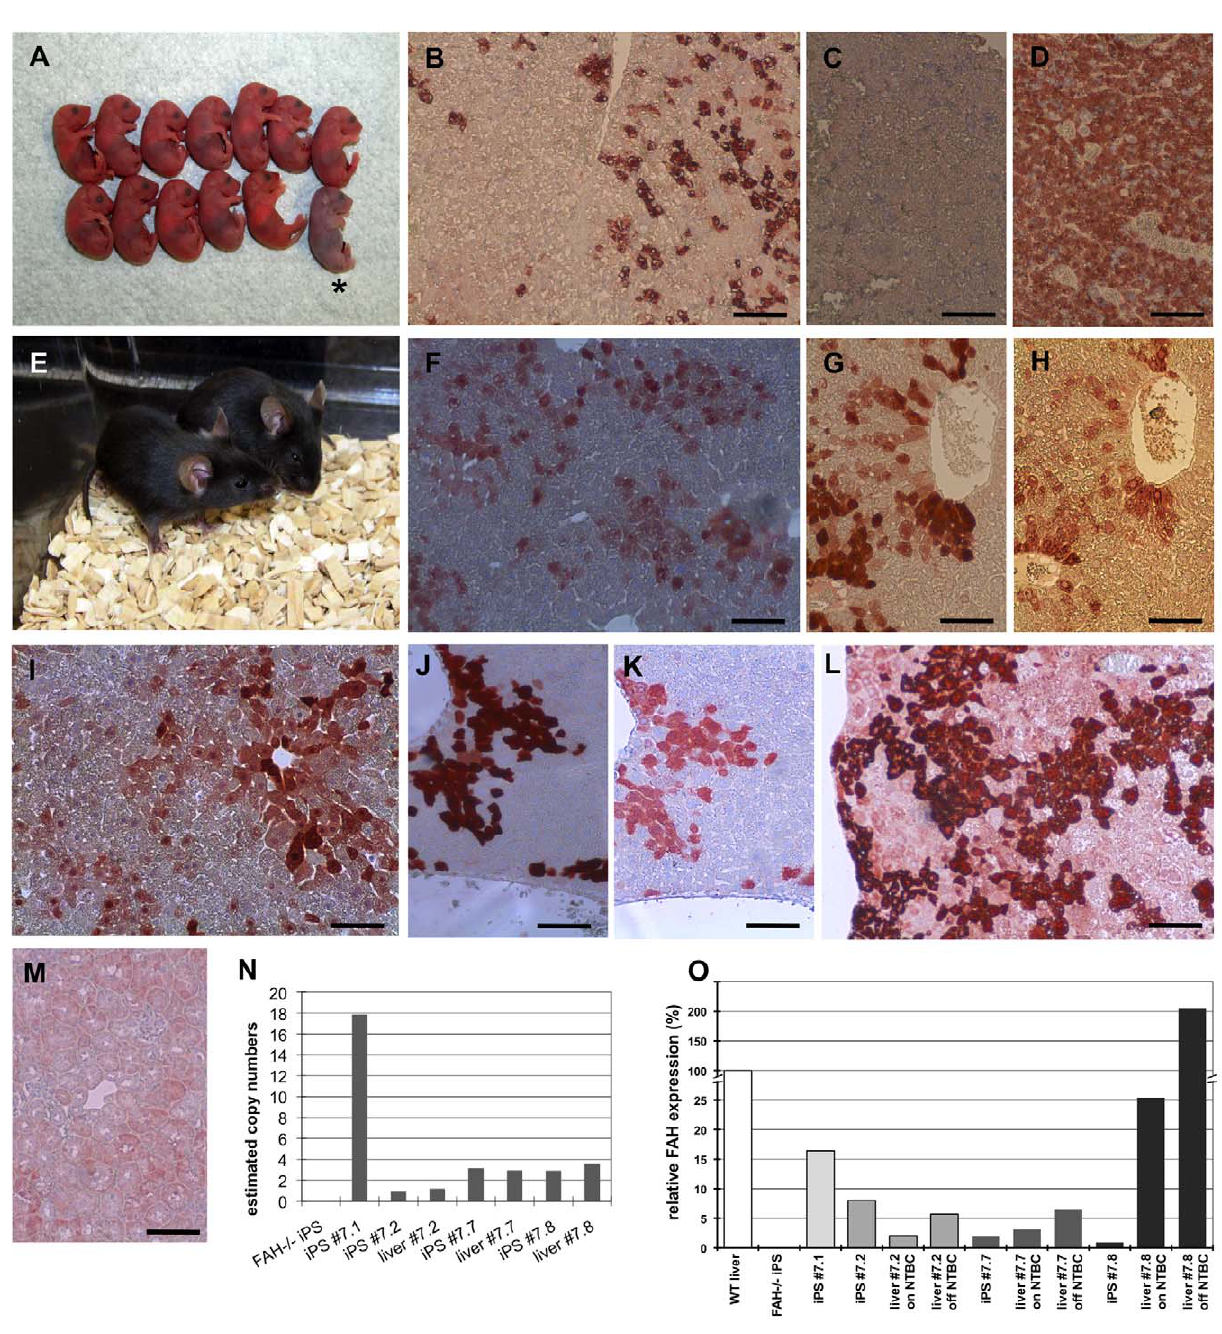
Figure5.Viablemicederivedfromgene-corrected FAH gc -iPScellsviatetraploidembryocomplementation. (A)Arepresentativelitterof FAH gc - IPS cell–derived neonatal pups. One of the pups failed to initiative breathing (*) after caesarean section delivery on E19.0. (B) Immunohistological staining